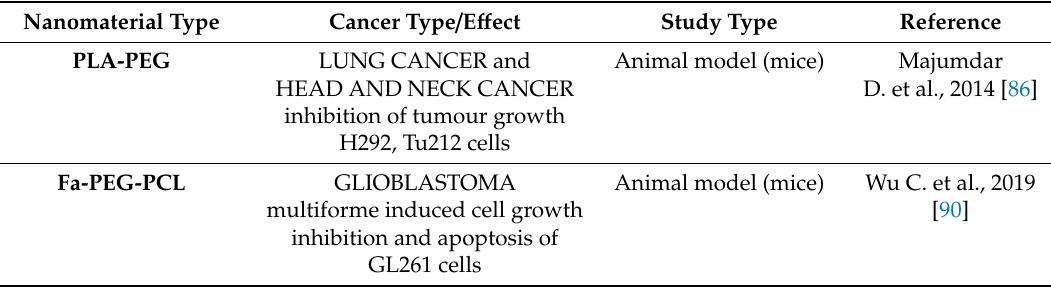
Table 7. Anticancer e ff ect of luteolin nanoparticles in in vivo